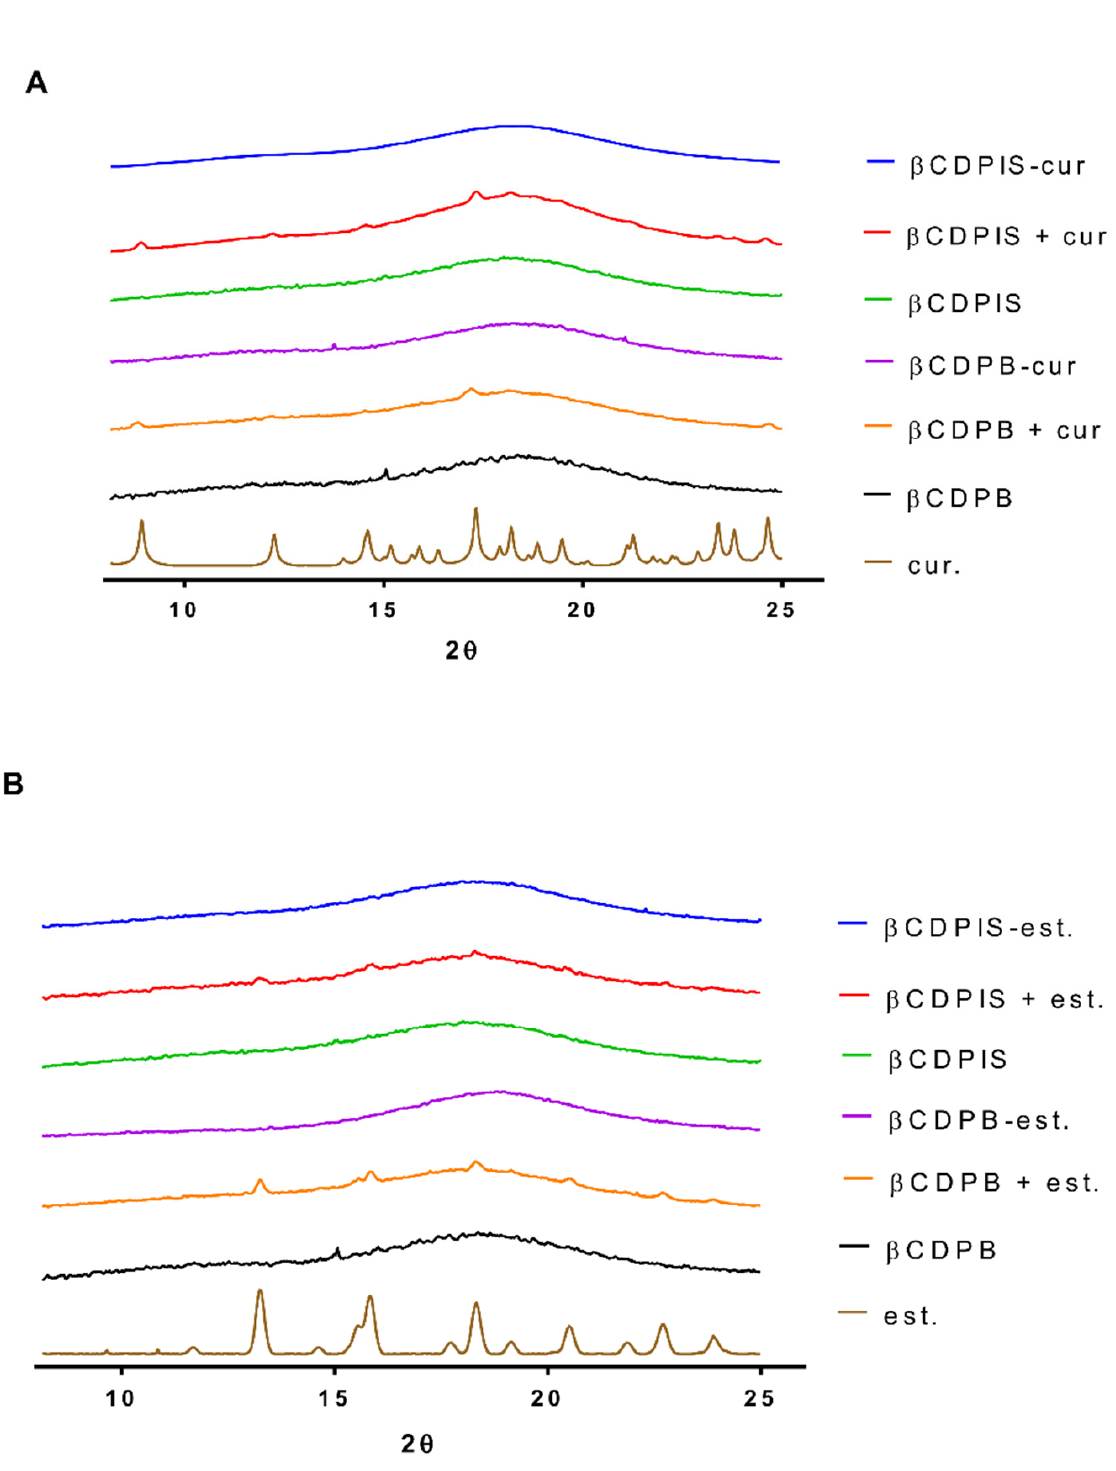
Figure 7. X-ray diffraction patterns of pure APIs, physical mixtures, and complexes. ( A ) Complexes and physical mixtures of curcumin (cur) with polymers. The crystal form of curcumin disappeared from the scatters after the complexation. ( B ) Changes in the crystallinity of estradiol (est) in different complexes. The nomenclature of complexes and physical mixtures contains “-“ and “+” symbols respectively.